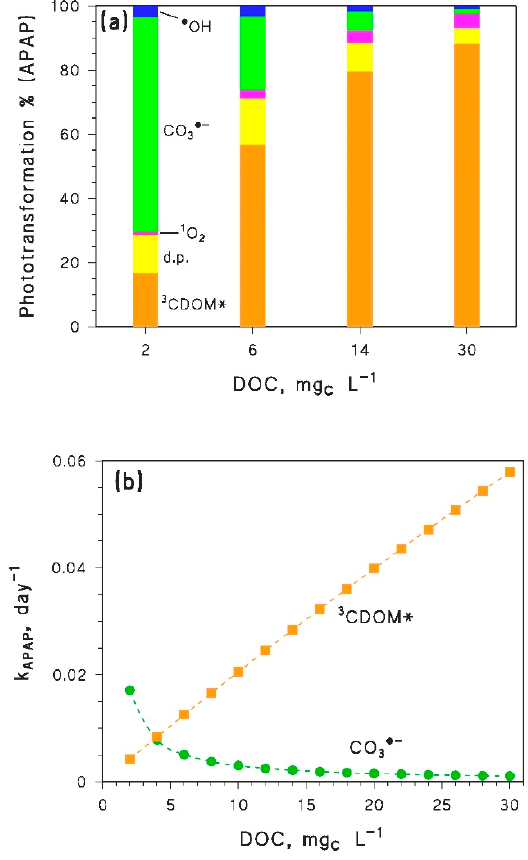
Figure 4. ( a ) Modeled contributions of • OH, CO 3 •− , 1 O 2 , 3 CDOM* and the direct photolysis (d.p.) to the photodegradation of APAP, for different values of the DOC. ( b ) DOC trends of the first order photodegradation rate constants of APAP, accounted for by CO 3 •− and 3 CDOM*. In both cases, it was DOC × d th = 45 m mg C L − 1 .